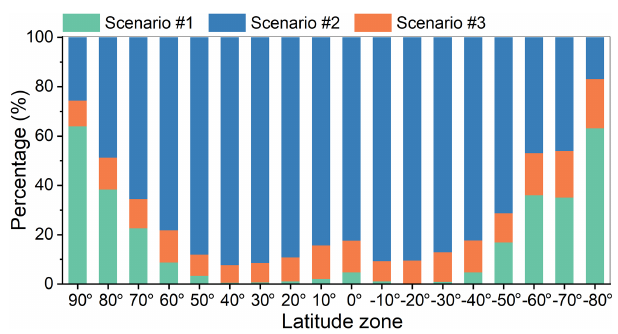
Figure 12. Percentage of each scenario (see Fig. 2) within 10 ◦ lat- itude intervals. For example, the number “ − 50” denotes the aver- aged percentage of each scenario within 50 to 60 ◦